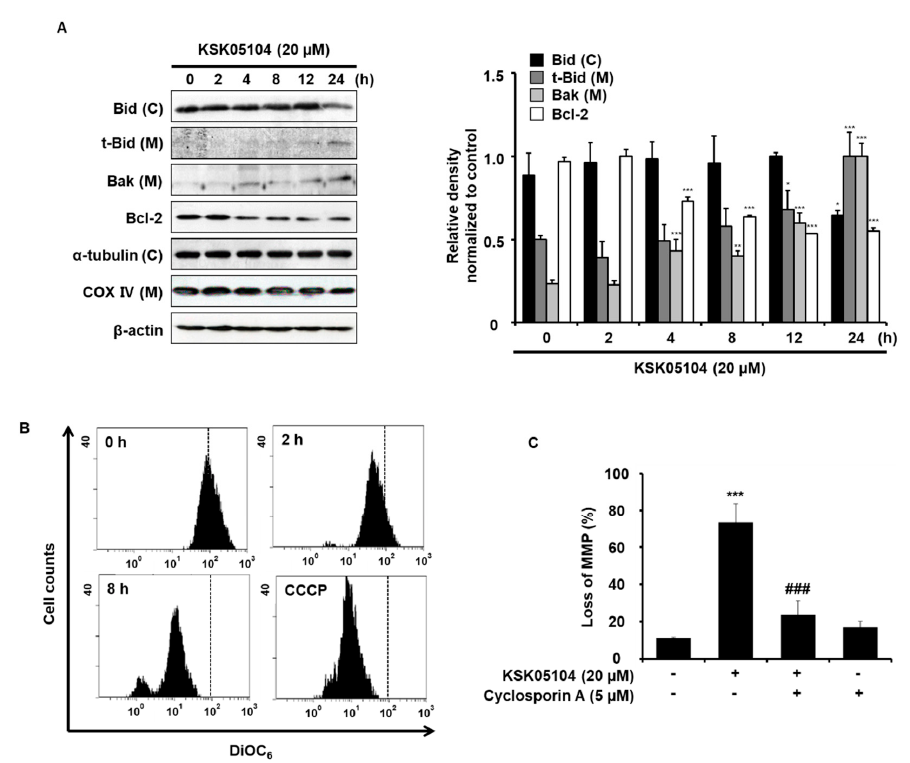
Figure 4. Effect of KSK05104 on the expression of Bcl-2 family proteins and mitochondrial membrane potential ( ΔΨ m ) in HT-29 cells. ( A ) Cells were treated with 20 μ M KSK05104 for 24 h and were then